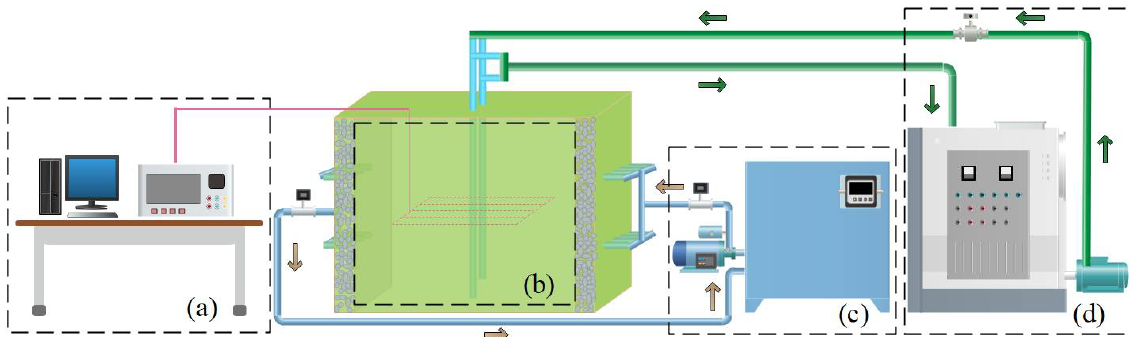
Figure 5. Freezing model test system ( a ) temperature acquisition and analysis system; ( b ) core test area; ( c ) constant-temperature brine circulation system; ( d ) freezing circulation system.